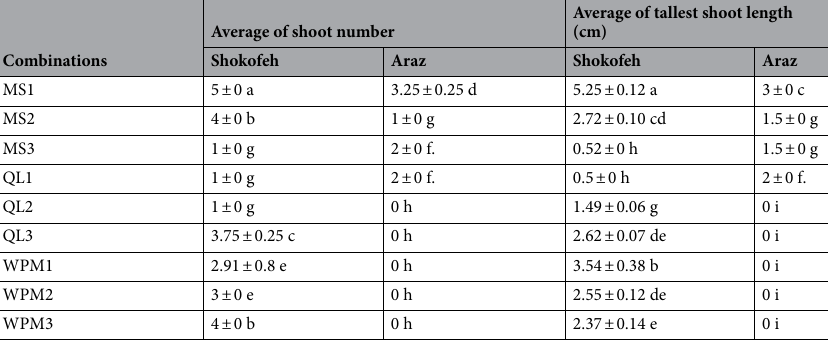
Table 3. Interaction effects of 2 cultivars × 3 media × 3 hormonal combinations on average of shoot number and tallest shoot length, after 4 weeks. The Figures 1, 2 and 3 on the side of each medium mean the